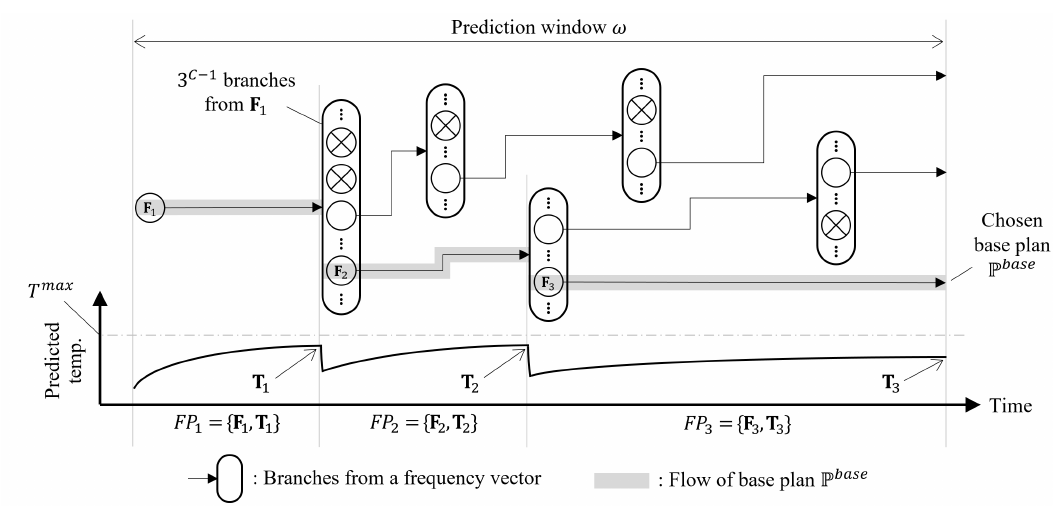
Figure 15. Finding a base plan in most-likely neighbor